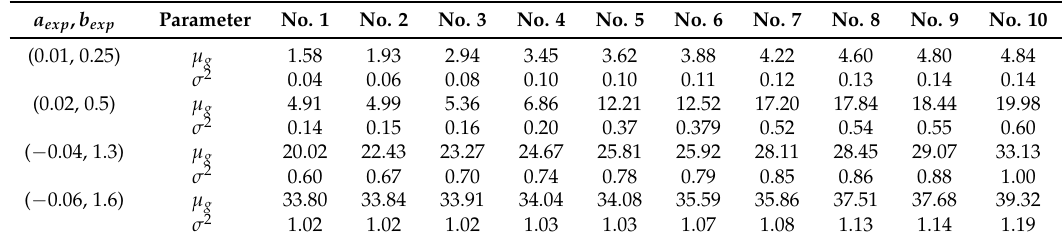
Table 1. Parameter settings of synthetic data